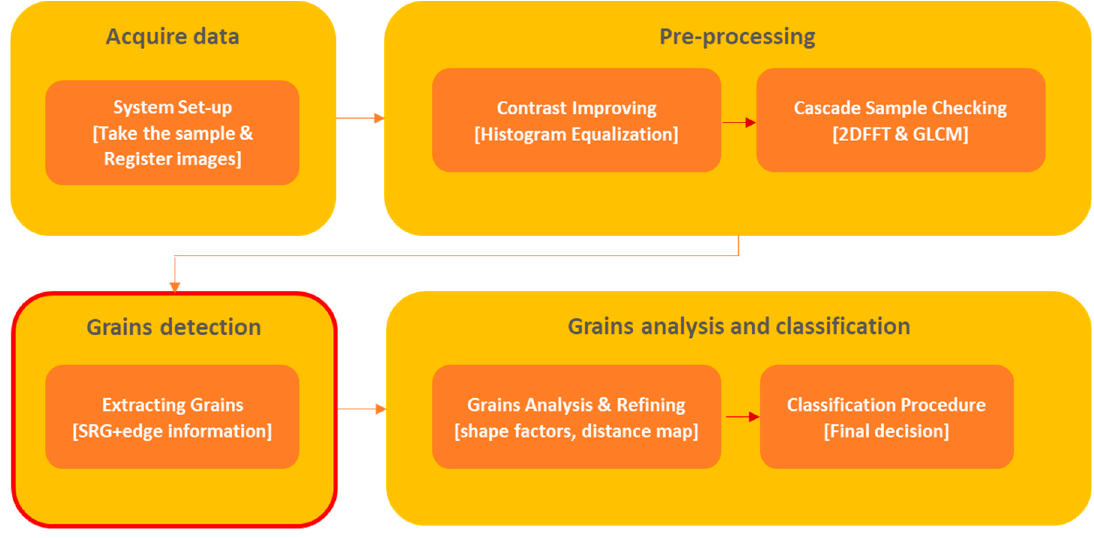
Figure 1. Block diagram of the proposed method.